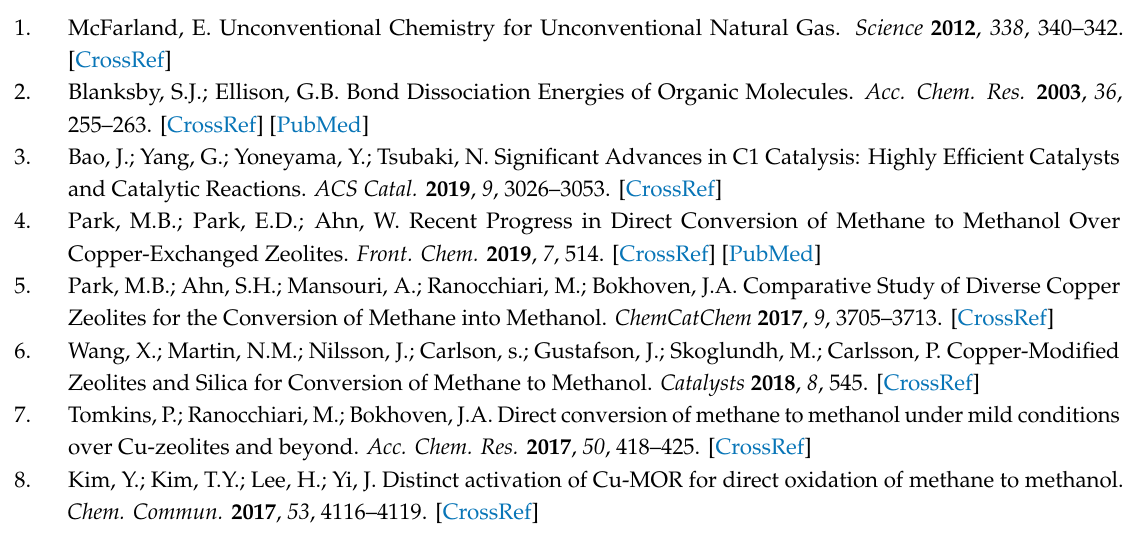
Table S1: Metal contents and BET surface area of Fe-zeolites, Table S2: Metal contents in Fe-zeolites before the reaction and in the liquid after the reaction, Table S3: Catalytic performance of 1.07 wt. % Fe-ZSM-5 and 1 wt. % Pd / AC at di ff erent reaction temperatures in the partial oxidation of methane, Table S4: E ff ect of pH on the performance of 0.766 wt. % Fe-ZSM-5 and 1 wt. % Pd / AC catalysts in the partial oxidation of methane, Table S5: E ff ect of 1 wt. % Pd / AC on the catalytic performance of 0.766 wt. % Fe-ZSM-5 and 1 wt. % Pd / AC in the partial oxidation of methane, Table S6: E ff ect of Fe content in Fe-ZSM-5 on the performance of Fe-ZSM-5 and 1 wt. % Pd / AC catalysts in the partial oxidation of methane; Table S7: Metal content in the liquid and the fraction of leached metal after the reaction with 1.07 wt. % Fe-ZSM-5 and 1 wt. % Pd / AC at di ff erent temperatures, Table S8: Metal content in the liquid and the fraction of leached metal after a reaction with 0.766 wt. % Fe-ZSM-5 and 1 wt. % Pd / AC at di ff erent pH, Table S9: Metal content in the liquid and the fraction of leached metal after a reaction with Fe-ZSM-5 containing di ff erent Fe contents and 1 wt. % Pd / AC catalysts, Table S10: Catalytic performance of di ff erent concentrations of 1 wt. % Pd / AC and FeSO 4 in the partial oxidation of methane, Table S11: Catalytic performance for partial oxidation of methane under di ff erent conditions, Figure S1: XRD patterns of (a) H-ZSM-5 and Fe-ZSM-5, (b) H-mordenite and Fe-mordenite, (c) H- β and Fe- β , (d) H-Y and Fe-Y, and (e) H-ferrierite and Fe-ferrierite, Figure S2: TEM image (a) and particle size distribution of Pd metal (b) of 1 wt. % Pd / AC. Author Contributions: J.K. and E.D.P. designed the experiments; J.K. performed and collected data; J.K.